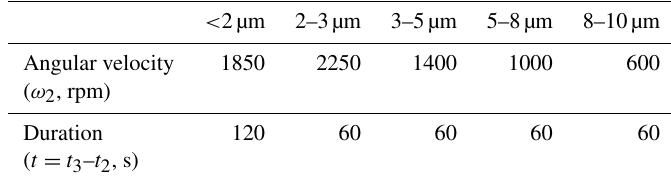
Table 2. Centrifugation parameters in the Miocene coccolith separations.